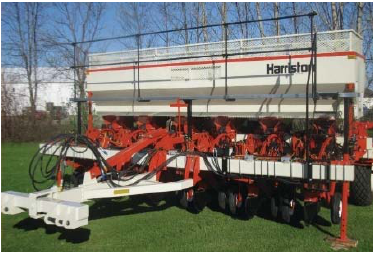
Figure 16. Harriston Clamp potato planter. Reprinted with permission from ref. [96] . Copyright 2020 Harriston Industries.